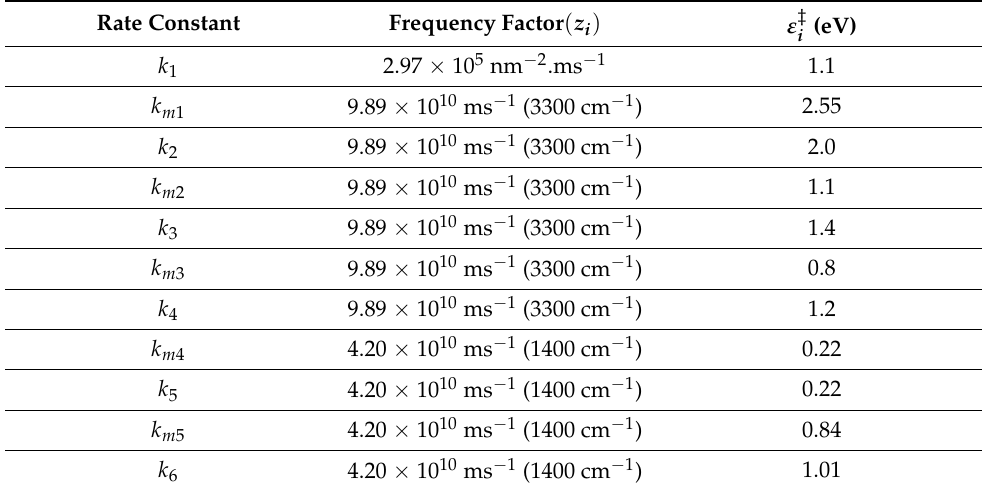
(cid:17) (cid:16) ε ‡ used in kinetic i